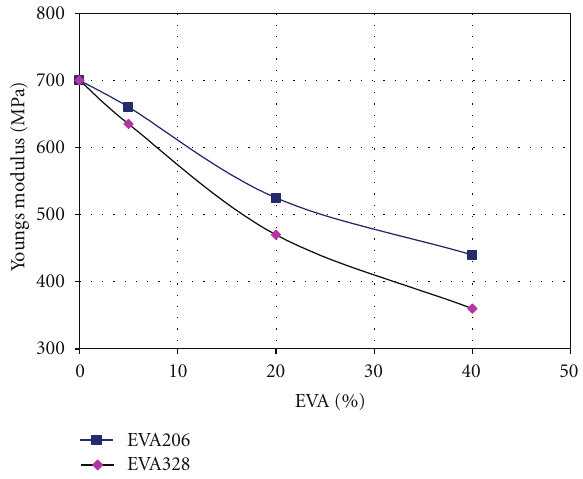
Figure 12: Variation of HDPE/EVA blends upper yield point with EVA contents and type.